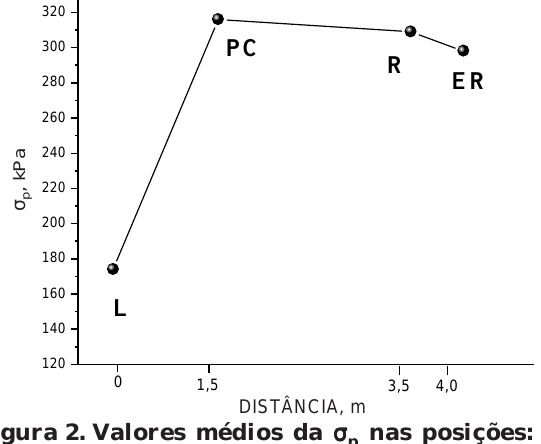
Figura 2. Valores médios da sssss nas posições: L p (linha), PC (projeção da copa), R (rodado) e ER (entre rodado), no potencial ( yyyyy ): -10 kPa, distanciadas a partir da L de 1,5 m (PC), 3,5 m (R) e 4,0 m (ER) na área de